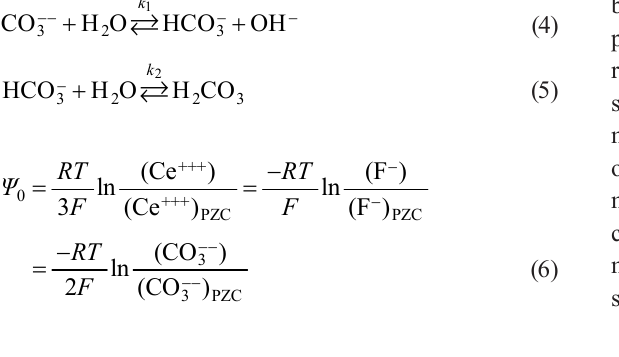
Table 2 Calculation of zeta potential vs log C slope for natural bastnaesite in carbonate solutions Total sodium carbonate